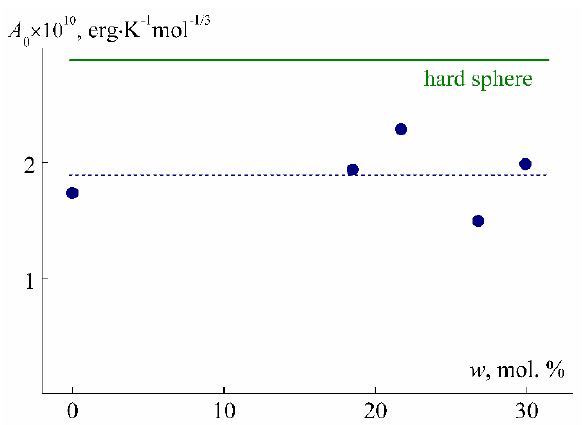
Figure 10. Dependence of hydrodynamic invariant A 0 on cross-linker content w for PEI-0 and PEI-n.